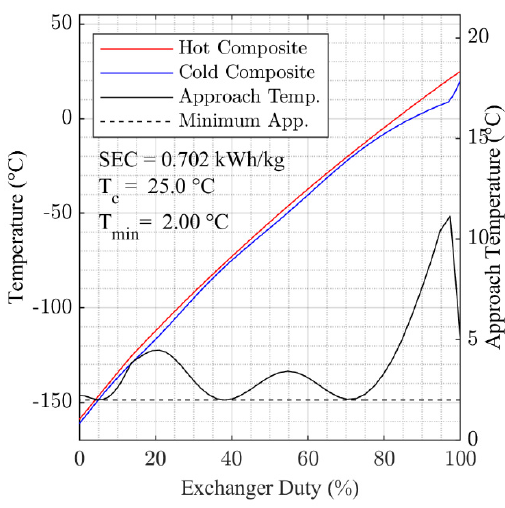
Figure A4 . Optimized composite cooling curves for 20°C cooling temperature.